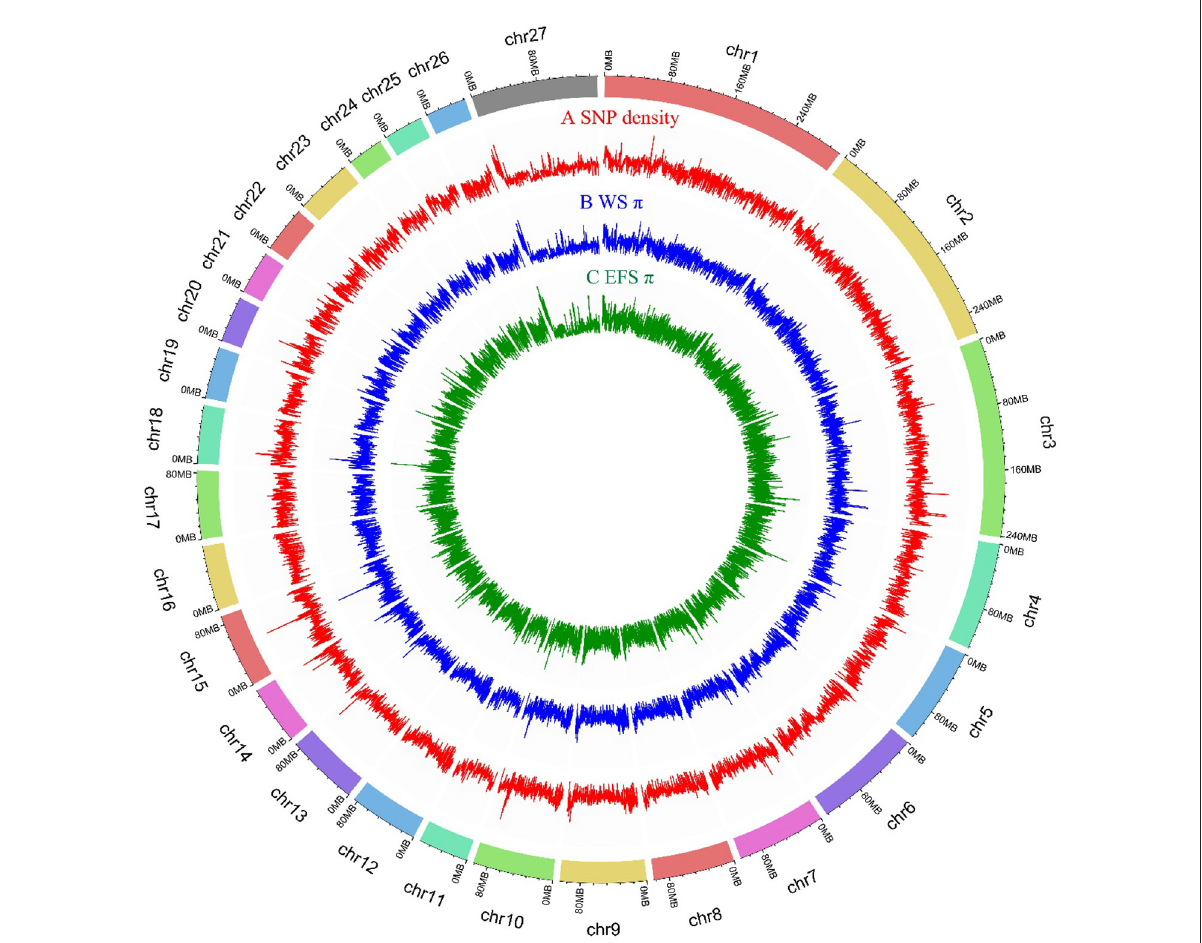
FIGURE1 Genome-wide distribution of SNP density and PI in 150kb size window. (A) Genome-wide distribution of SNP density within 150kb window. (B) Genome-wide distribution of PI for WS population in 150kb size window. (C) Genome-wide distribution of PI for EFS population in 150kb size